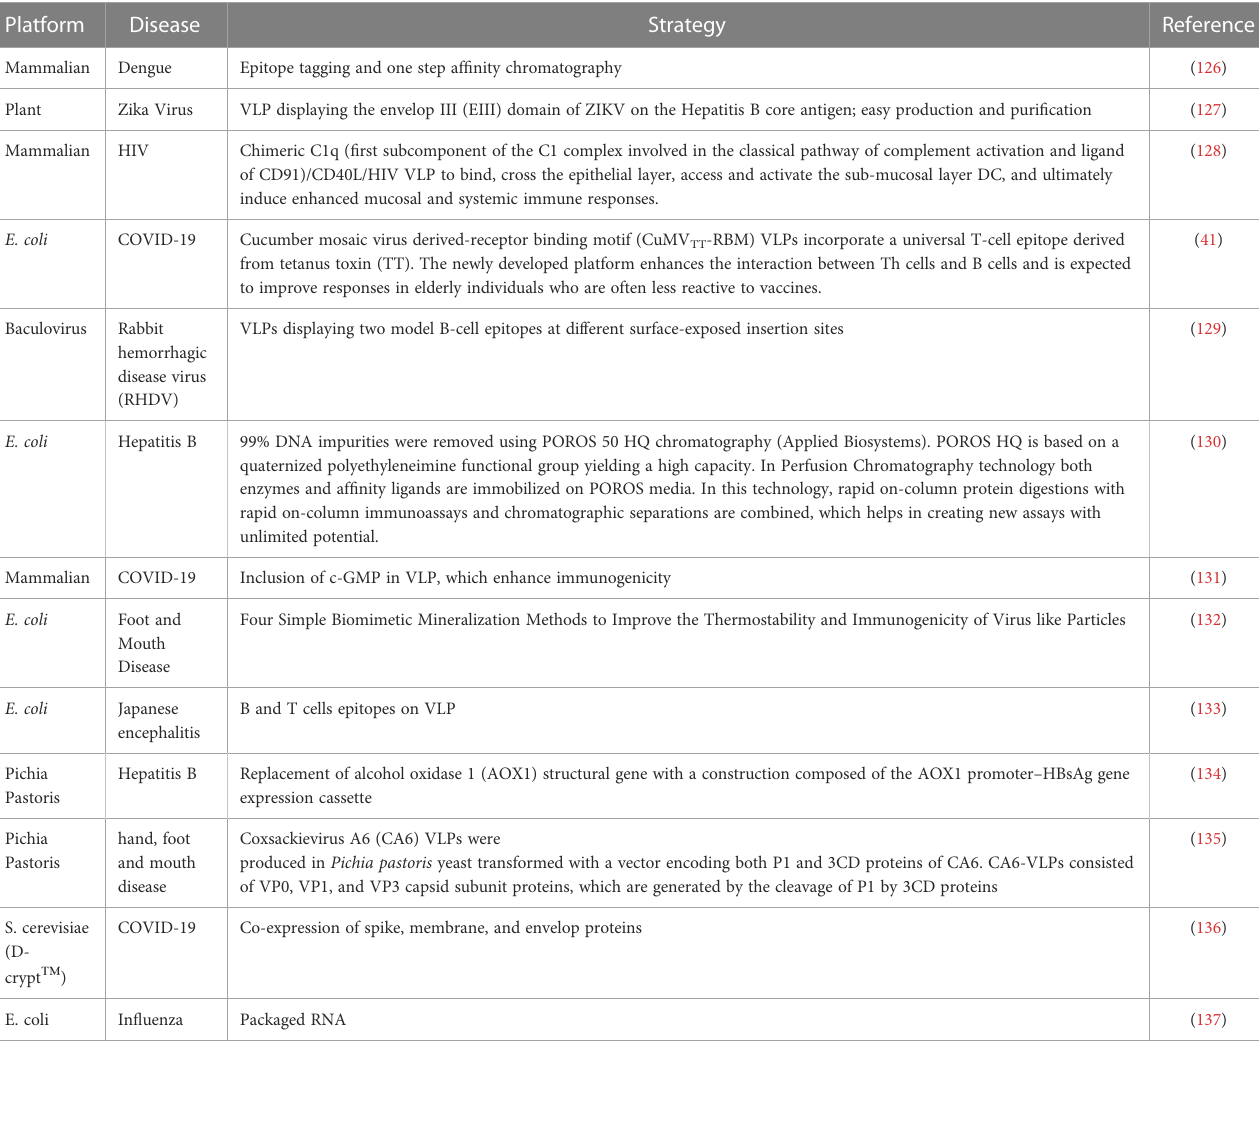
TABLE 5A VLPs based vaccine candidates in clinical trials.